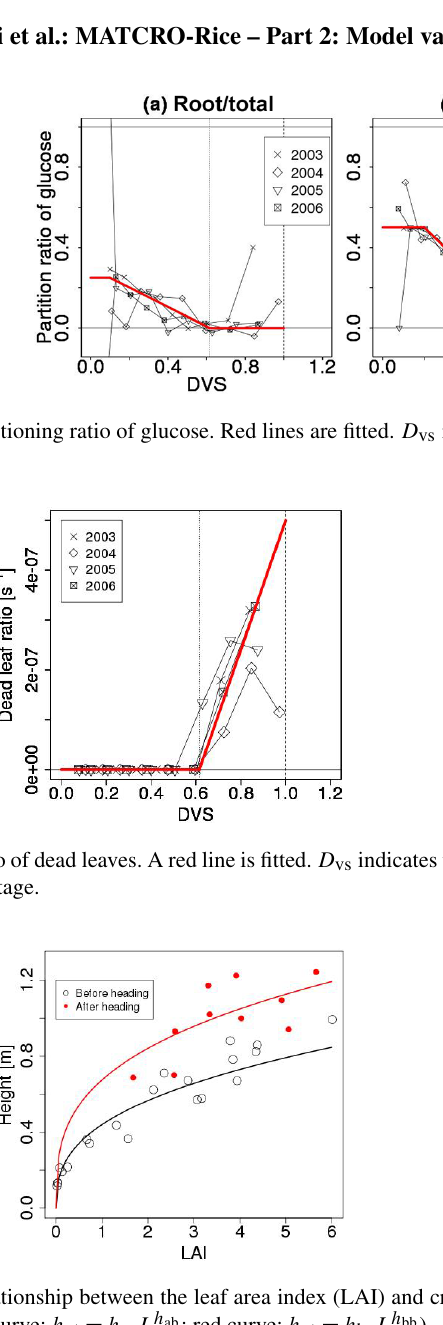
Figure 6. RuBisCO-limited photosynthesis